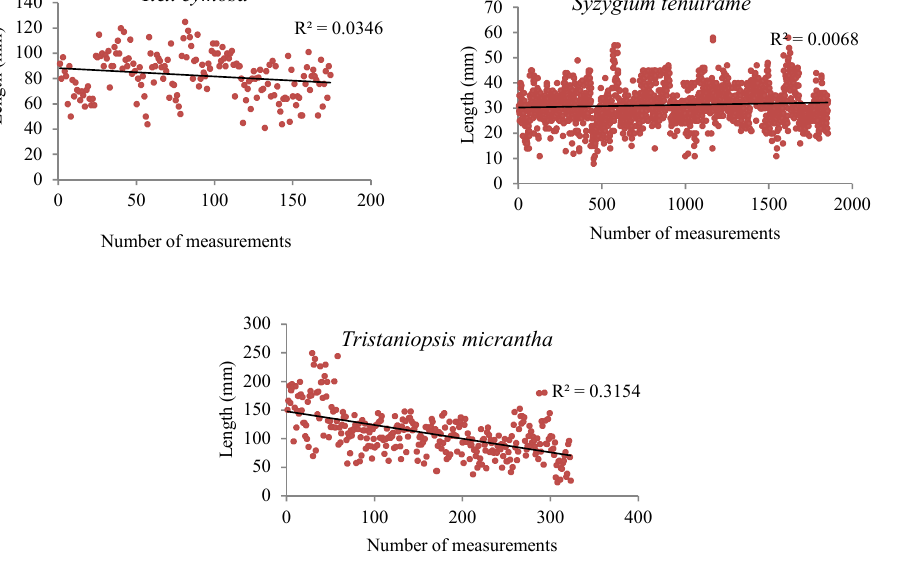
Fig. 3: Variation of leaf lengths of all the species used Leaf-size classification